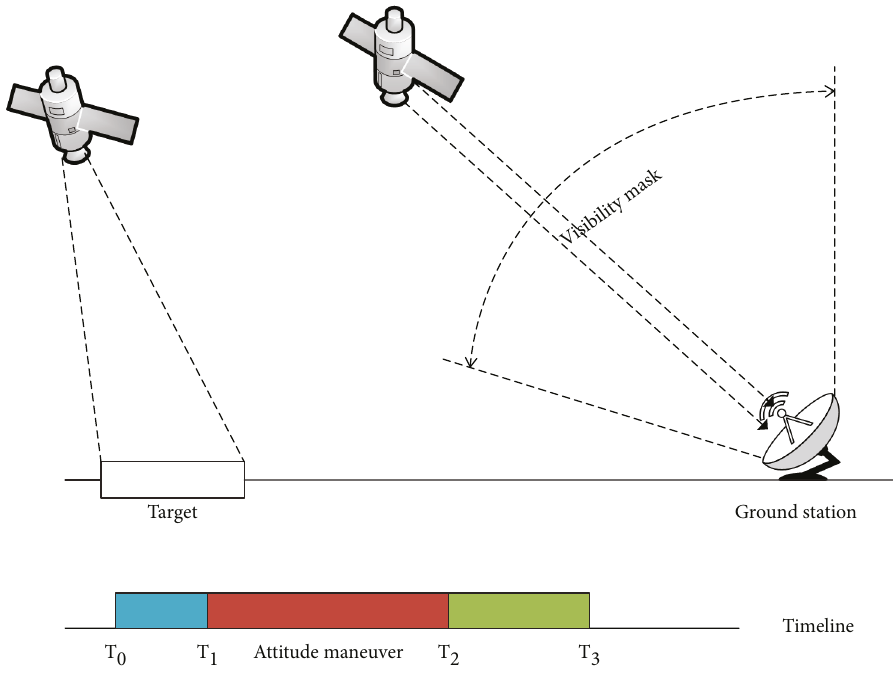
Figure 1: The diagram of imaging satellite data downlink